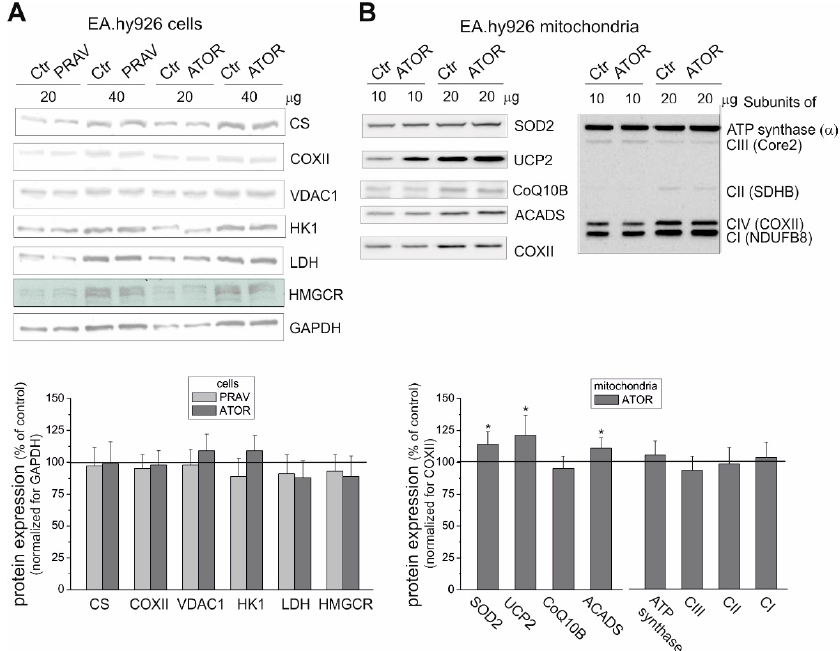
Figure 2. Representative Western blots (above) and analyses of the protein expression (below) in endothelial cells grown with 100 nM PRAV or 100 nM ATOR ( A ) and in mitochondria isolated from ATOR ‐ treated cells ( B ). CS: citrate synthase; COXII: cytochrome c oxidase subunit II; VDAC 1: voltage ‐ dependent anion ‐ selective channel protein 1; HKI: hexokinase I; HMGCR: HMG ‐ CoA reductase; GAPDH: glyceraldehyde 3 ‐ phosphate dehydrogenase; SOD2: superoxide dismutase 1; UCP2: uncoupling protein 2; ACADS: acyl ‐ coenzyme A dehydrogenase; CoQ10B: mitochondrial coenzyme Q ‐ binding protein CoQ10 homolog B; CI–CIV: complexes of respiratory chain. Mean ± SD; n = 5 ‐ 10; p < 0.05 (*), comparison vs. control values.